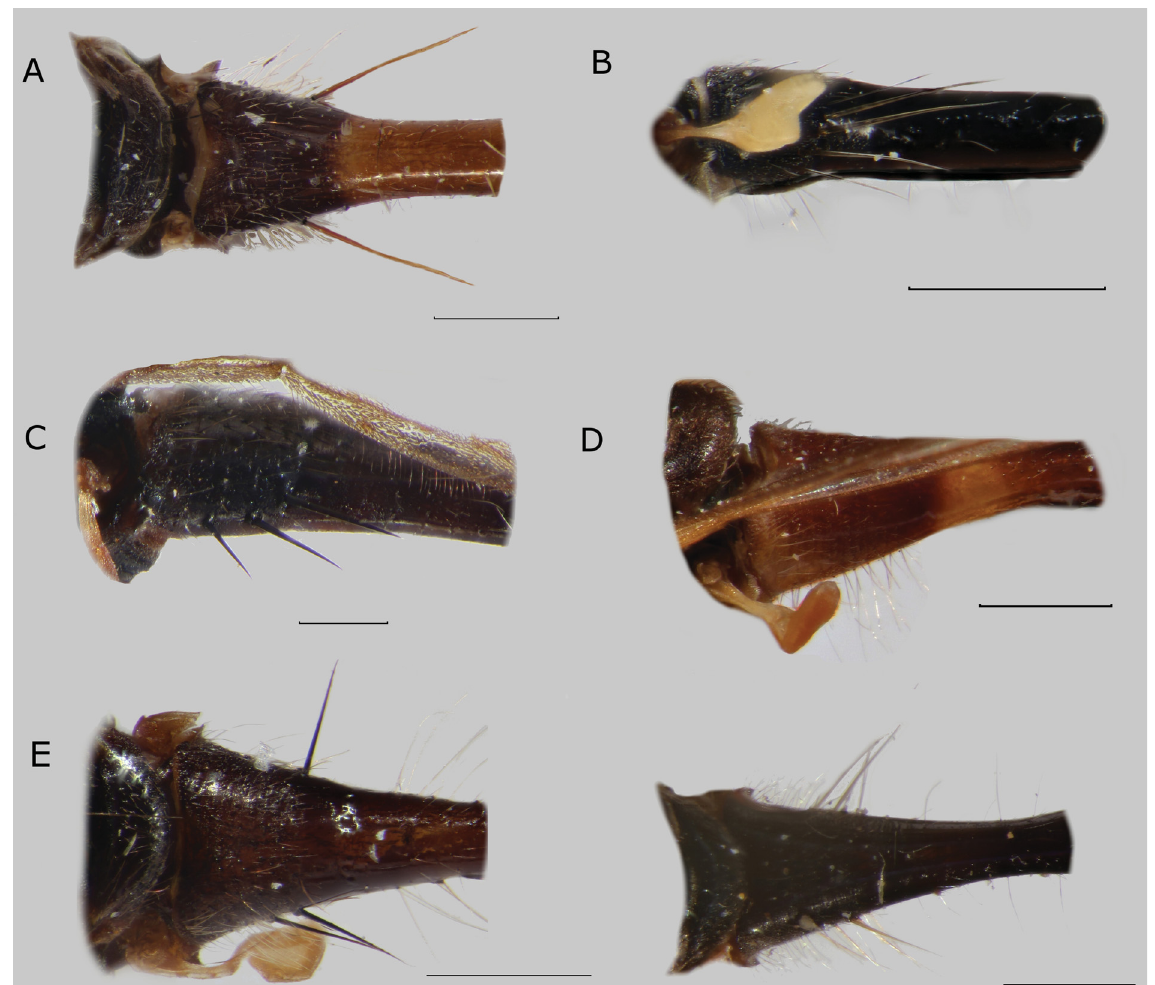
Fig. 77. Tergum I, dorsal view (A, E–F) and lateral view (B–D). A . Sph egina (Asiosphegina) miri fi ca Hippa, van Steenis & Mutin, 2015, ♀ , Myanmar. B . S. (A.) nigerrima Shiraki, 1930, ♂ , Taiwan. C . S. (A.) bispinosa Brunetti, 1915, ♂ , Nepal. D . S. (A.) philippina Thompson, 1999, paratype, ♀ , Philippines. E . S. (A.) raduloides Hippa, van Steenis & Mutin, 2015, paratype, ♂ , Myanmar. F . S. ( A. ) cf. spathigera sp. nov., ♀ , Philippines. Scale bars = 0.5